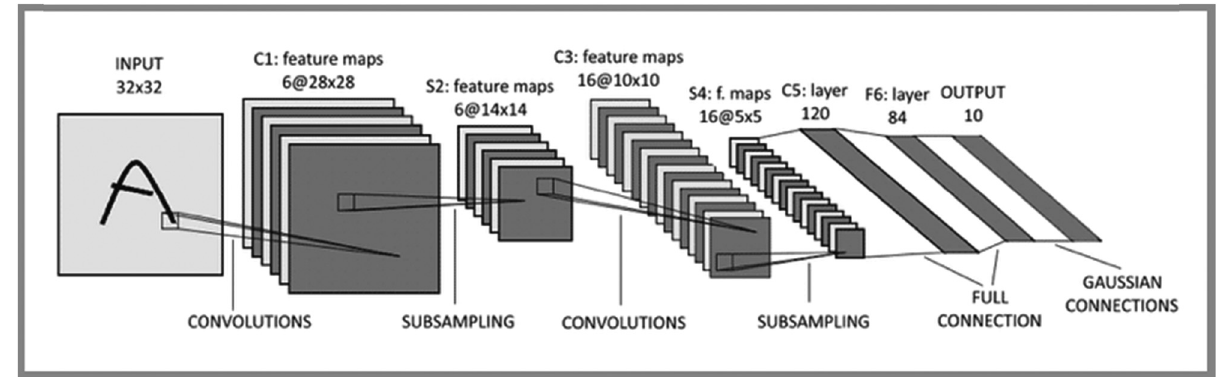
Figure 6: Typical CNN structure used in LeNet -